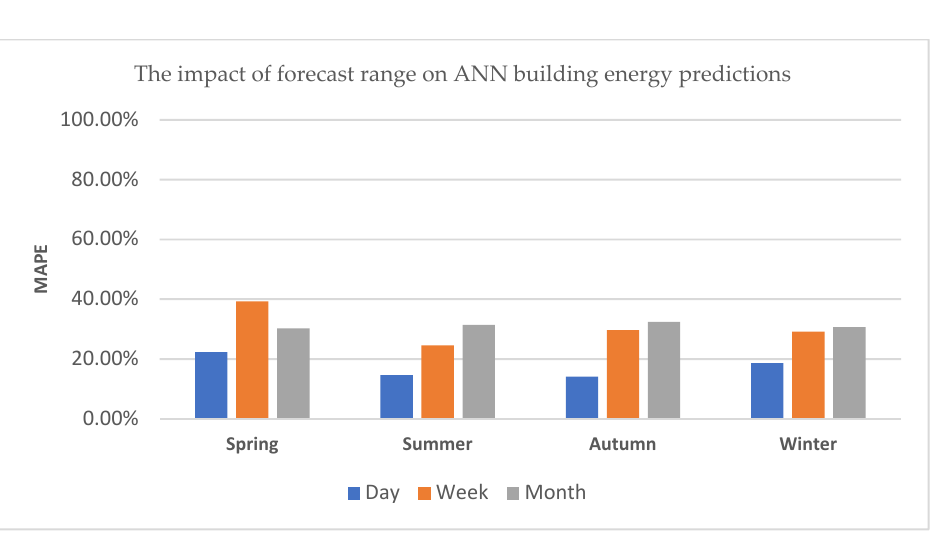
Figure 16. A comparison of SVR prediction MAPEs.